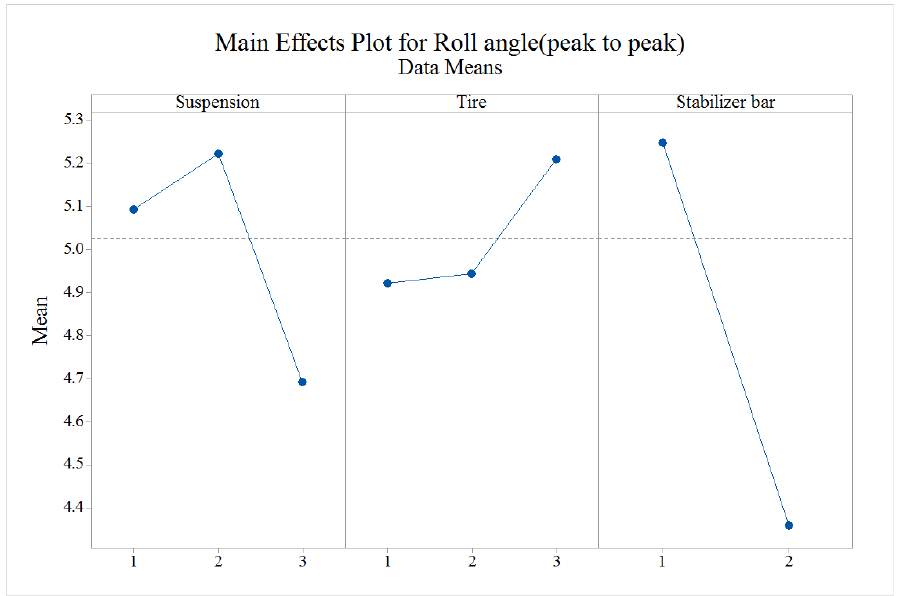
Figure 13. Suspension and tire test results with stabilizer bar (double-lane change; roll angle).